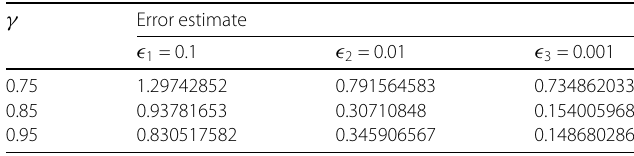
Table 1 The error between the regularized and exact solutions at γ ∈ { 0.75,0.85,0.95 } and (cid:8) ∈ { 0.1,0.01,0.001 } γ Error estimate (cid:8) 1 = 0.1 (cid:8) 2 = 0.01 (cid:8) 3 = 0.001 0.75 1.29742852 0.791564583 0.734862033 0.85 0.93781653 0.30710848 0.154005968 0.95 0.830517582 0.345906567